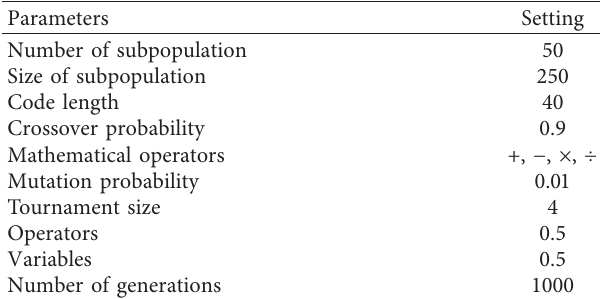
Table 2: Optimum parameter setting for